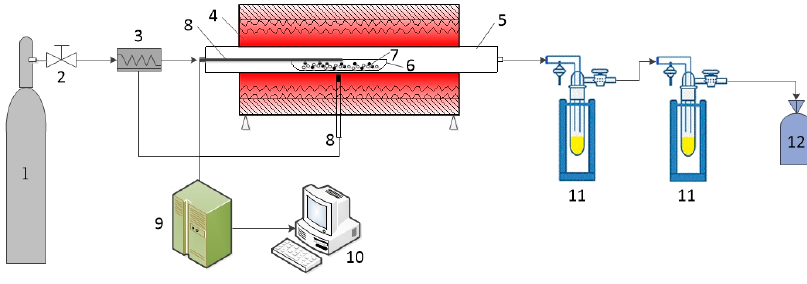
Figure 1. Schematic diagram of the experimental setup for pyrolysis.